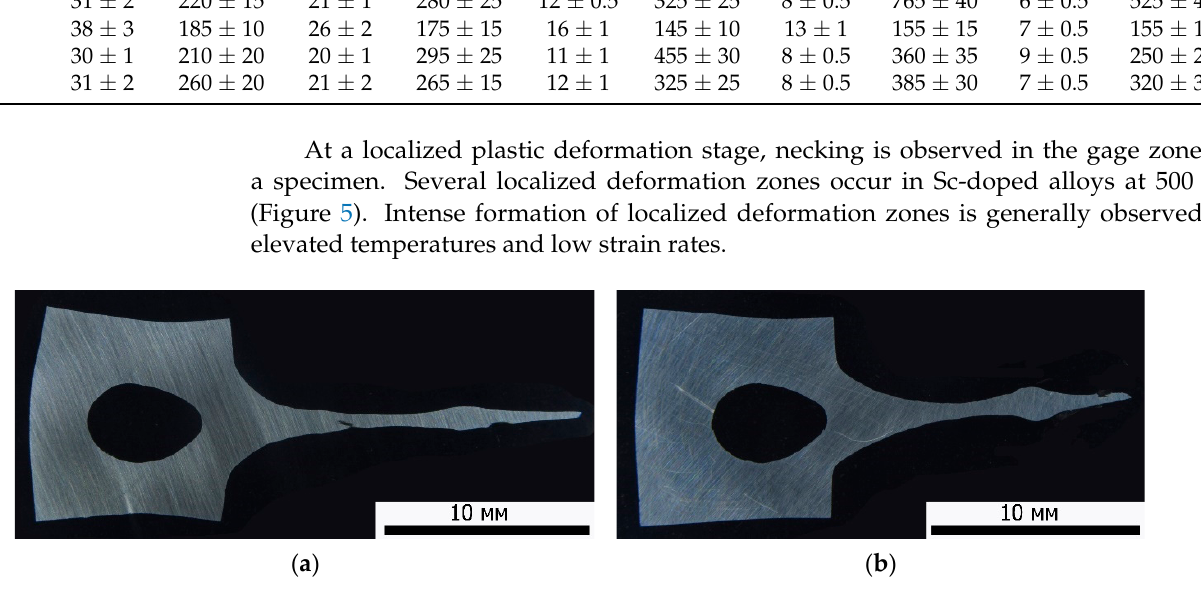
Figure 4. σ ( ε ) curves in UFG alloys: series Nos. 1 ( a ) and 5 ( b ). Tests at elevated temperatures (°C) and a strain rate of 3.3 × 10 − 3 s − 1 .